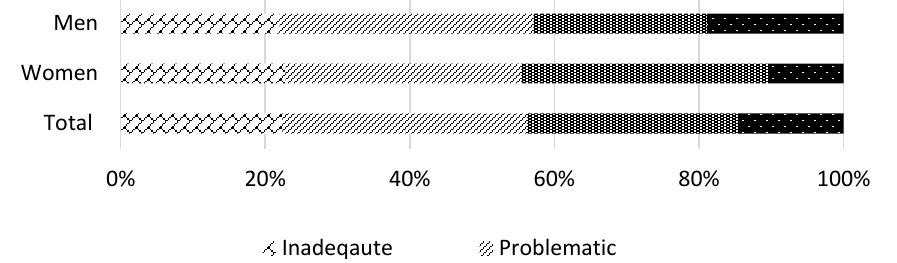
Table 2. Characteristics of the participants by health literacy (HL)